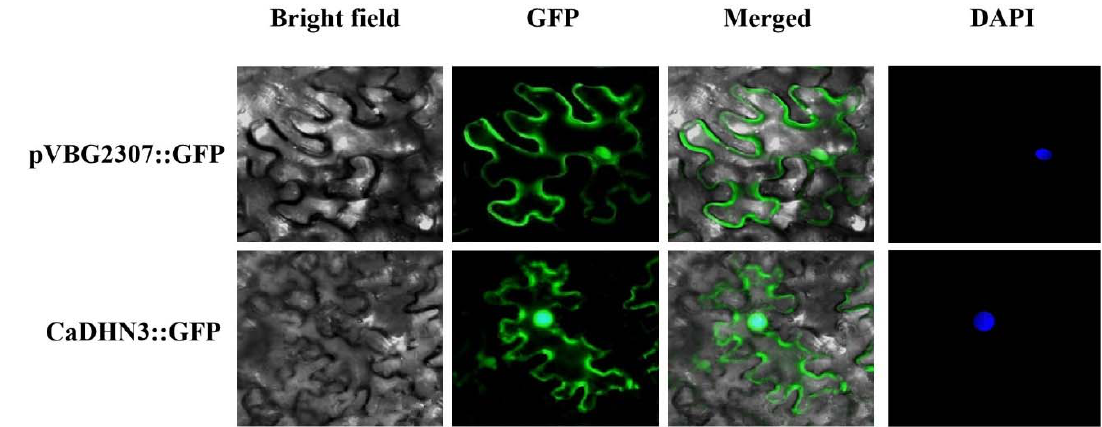
Figure 1. The sub-cellular localization of pepper CaDHN3. Agrobacterium tumefaciens strain GV3101 with pVBG2307:CaDHN3:GFP and pVBG2307:GFP (as control) vectors were transiently expressed in N. benthamiana leaves. Bars in this picture are 50 µm.